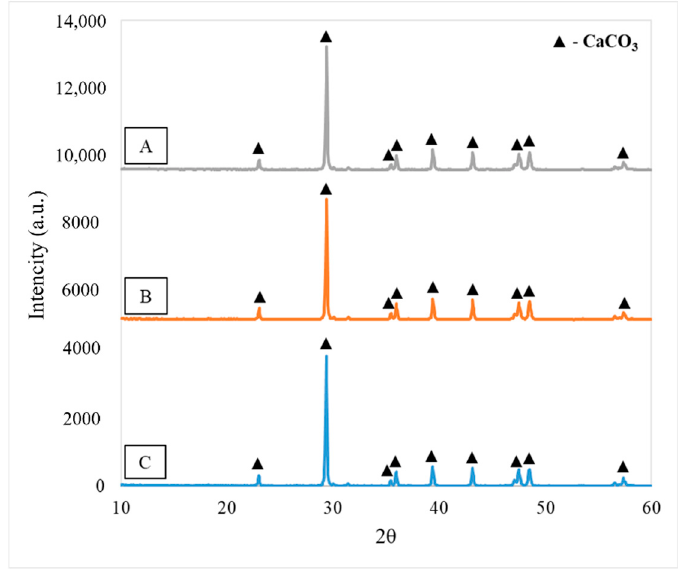
Figure 1. Diffractogram patterns of tested materials (( A )—sample A, ( B )—sample B, ( C )—sample C).